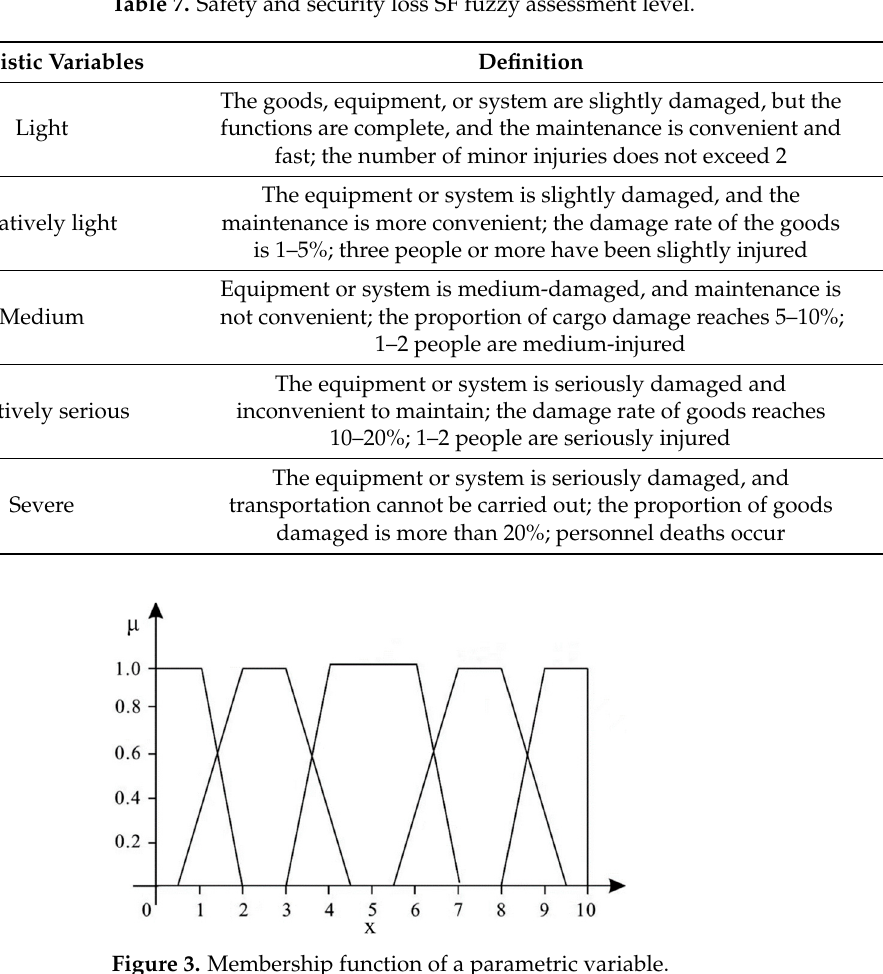
Figure 3. Membership function of a parametric variable.